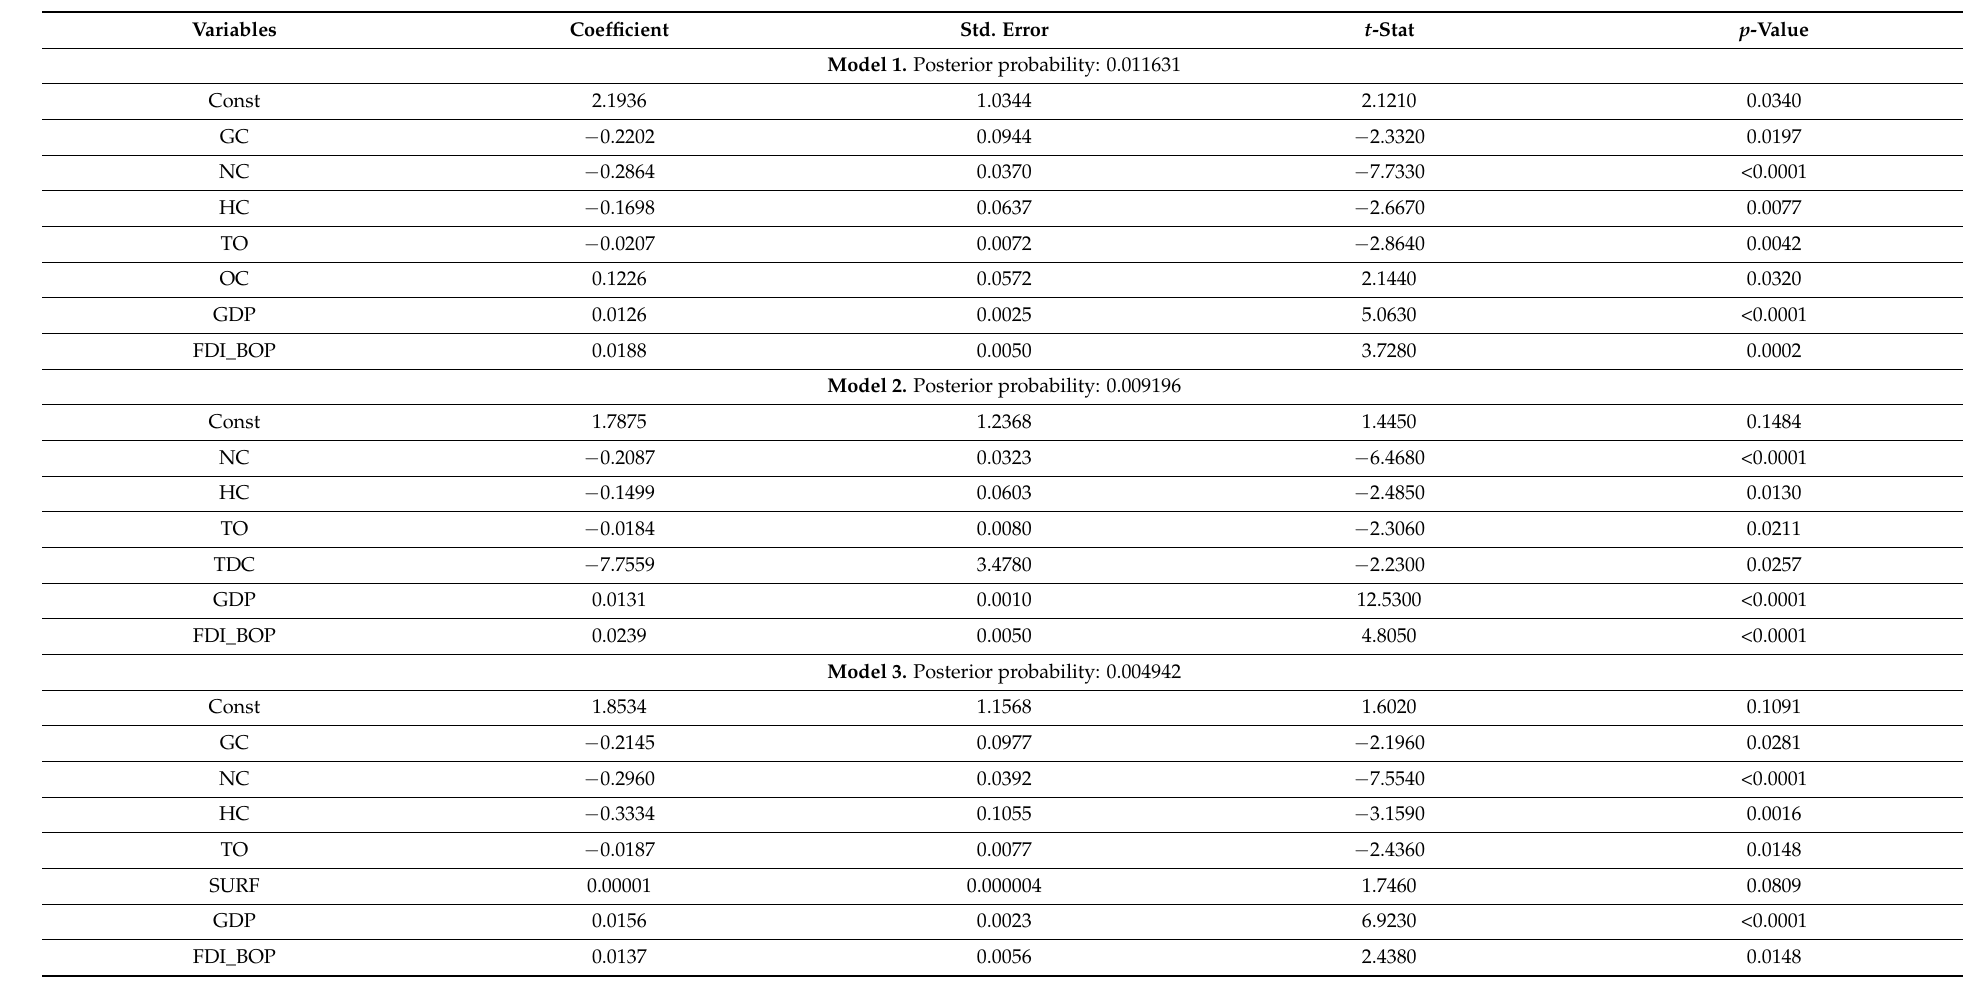
Table A4. Posterior estimates of top 3 models for renewable consumption determinants in